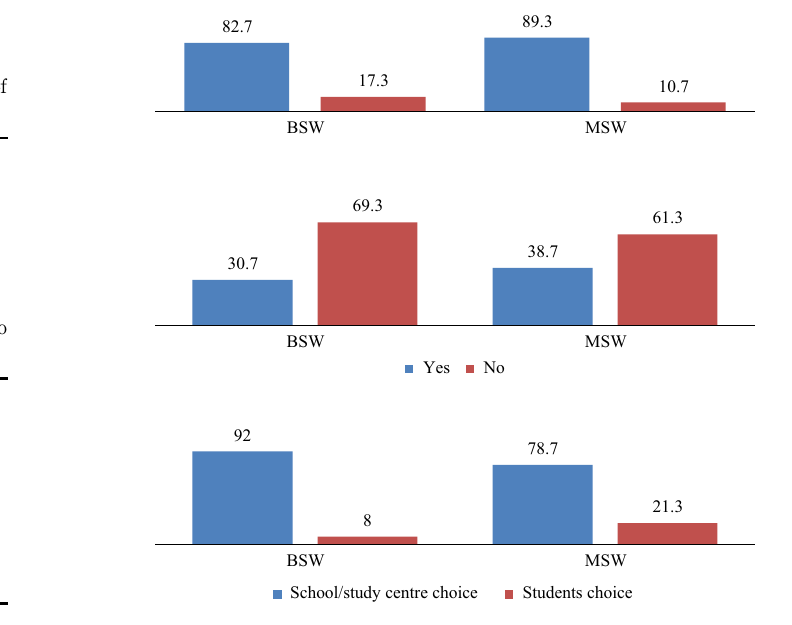
Figure 13. Awareness about various components of field work practice